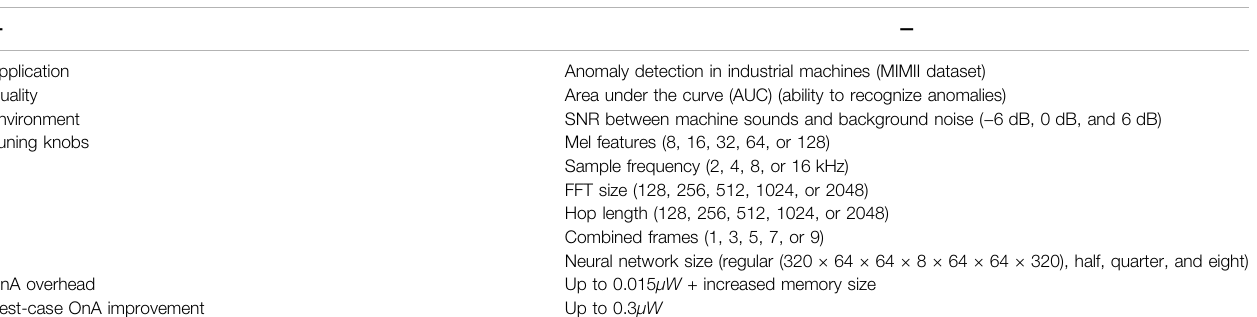
TABLE 3 | Overview of fl exible TKs in the anomaly detection study by De Roose et al. (n d). — — Application Anomaly detection in industrial machines (MIMII dataset) Quality